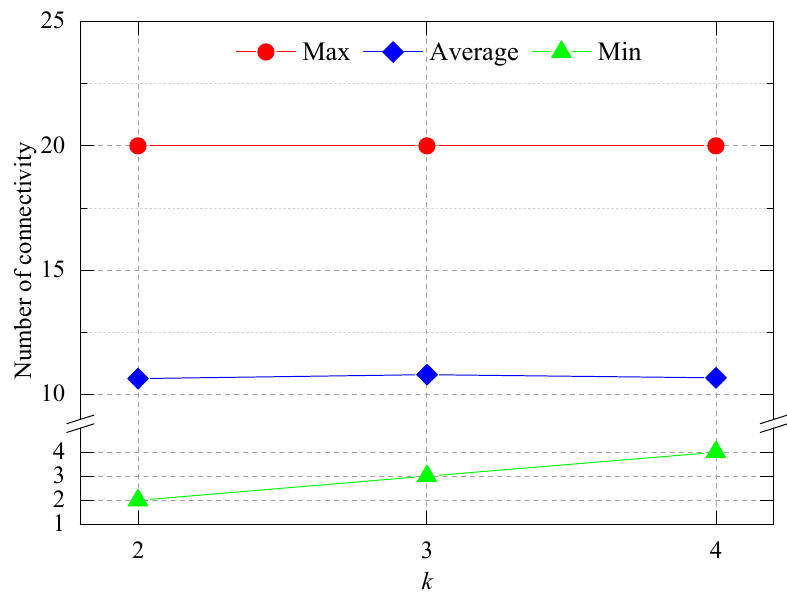
Figure 17. Network connectivity for different values of k.